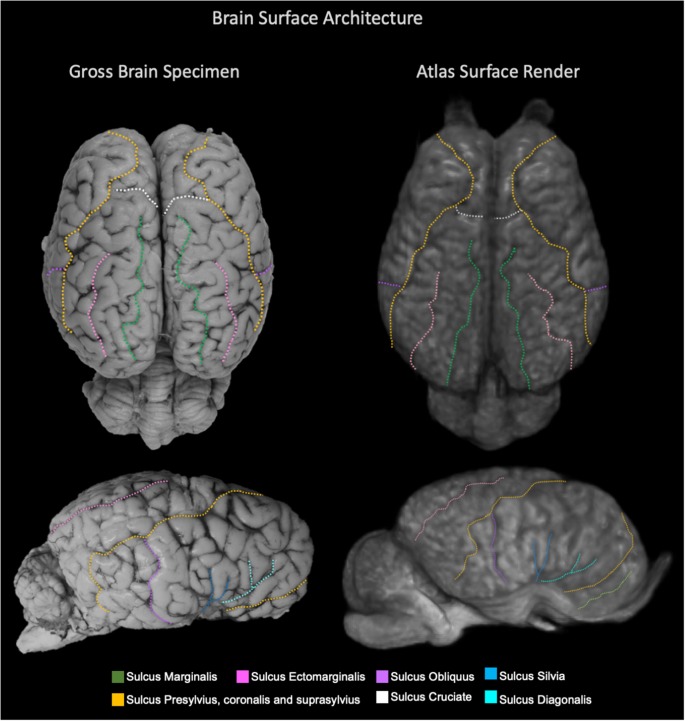
Labeled images demonstrating the surface architecture of the atlas (right) in comparison with an anatomic specimen (left). Images of the dorsal (top) and lateral (bottom) brain surfaces are provided and the sulci are labeled. Sulci included; marginalis (green), ectomarginalis (pink), obliquus (purple), silvia (blue), presylvius, coronalis and suprasylvius (yellow), cruciate (white) and diagonalis (turquoise).